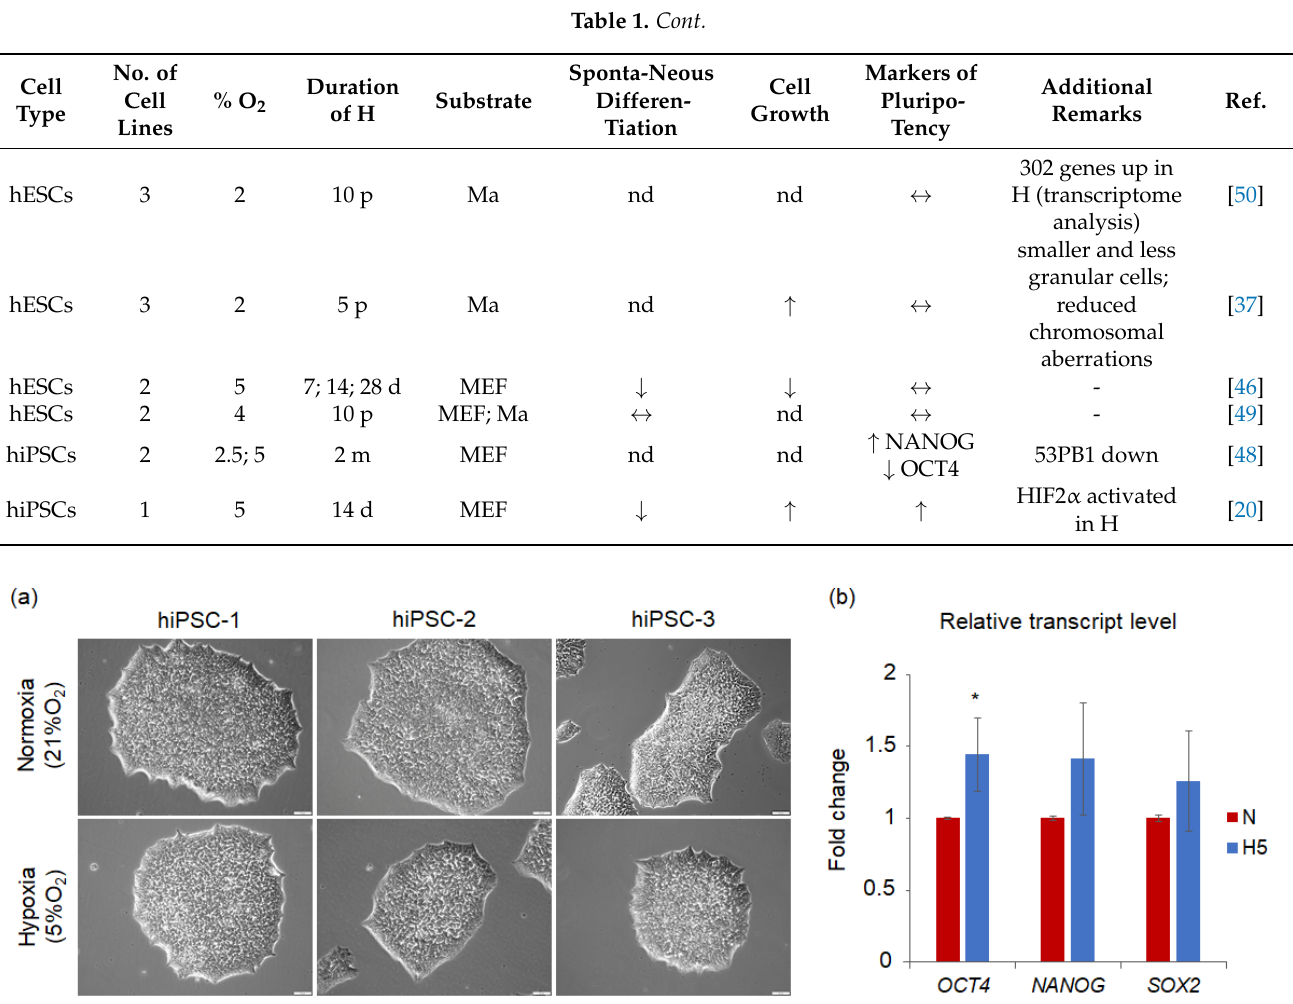
Figure 2. Morphology and expression level of pluripotency-associated genes in three hiPSC lines, cultured in either normoxia (21% O 2 ; N) or hypoxia (5% O 2 ; H5). hiPSCs were continuously cultured in respective oxygen conditions for 4 passages, in StemFlex (Gibco), on Geltrex (Gibco)-coated dishes. ( a ) Representative pictures of hiPSC colonies were acquired with the Leica DMI6000B v. AF7000 microscope (Leica Microsystems). Scale bar is 50 µm; ( b ) relative expression levels of OCT4 , NANOG , and SOX2 genes in hiPSCs measured with the ΔΔ Ct method using 18SRNA as a calibrator. The graph shows the mean ± SD. Student’s t -test was used to compare the expression between the groups. * Statistical significance at p < 0.05 is indicated with an asterisk.